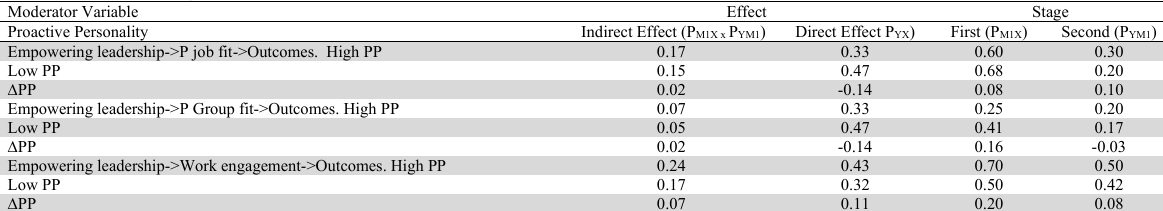
Moderated mediating results Moderator